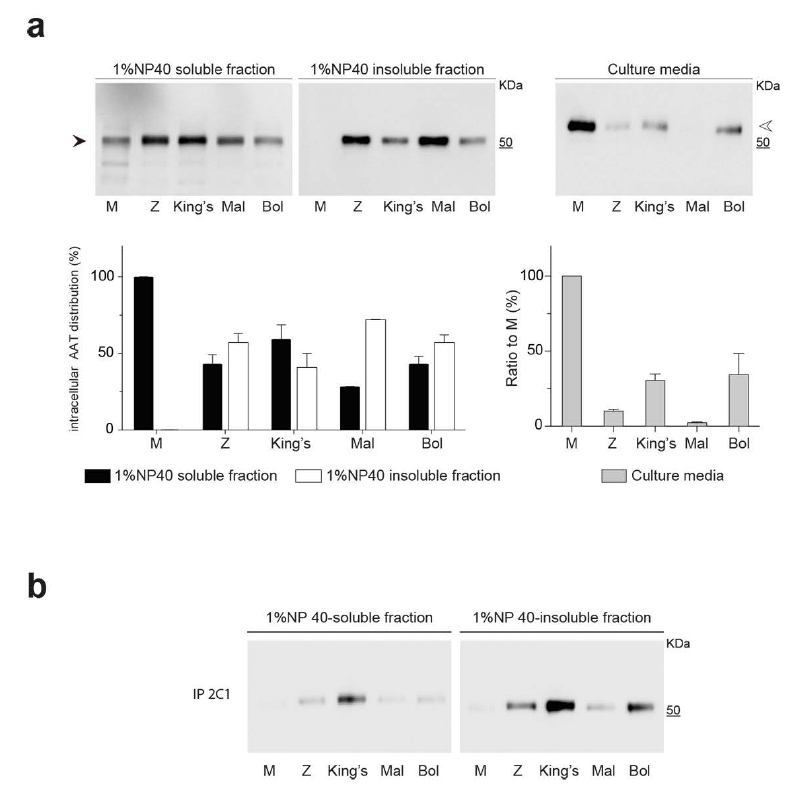
Figure 2. Cellular handling of Bologna AAT. ( a ) Hepa 1.6 cells were transfected to express wild-type M, Bologna (Bol) or the polymerogenic AAT variants Z, Mmalton (Mal) and King’s. Forty-eight hours after transfection, the culture media were collected, and the cells were lysed in 1% v / v NP-40 buffer. The NP-40-soluble and -insoluble cellular fractions and the cell media were separated by 4–12% w / v acrylamide SDS-PAGE and AAT was detected by immunoblotting with a polyclonal antibody (Dako). Black and white arrowheads indicate high-mannose and complex N -glycosylated forms of AAT, respectively. AAT levels in the two cellular fractions (expressed as percentage of total intracellular AAT) and in the cell media (expressed as percentage of secreted M AAT) were determined by densitometric quantification and reported in the graphs as mean ± SEM ( n = 3). ( b ) Soluble and insoluble intracellular fractions prepared as in panel A were